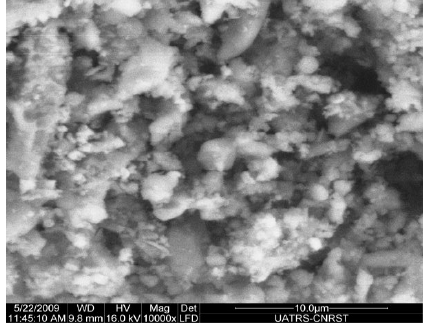
Figure 14. SEM of the reaction product Z’B6 (synthesized with 8 M